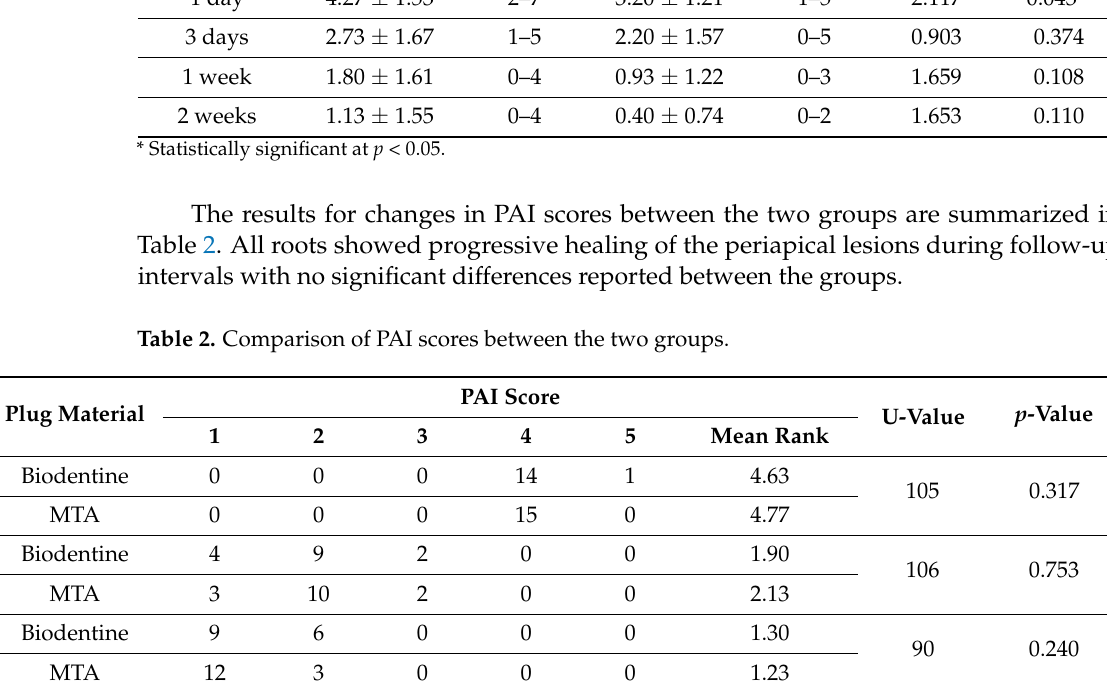
Table 1. Comparison of postoperative pain (measured with VAS scale) between the two groups. Biodentine MTA Follow-up Range Mean ± SD Baseline